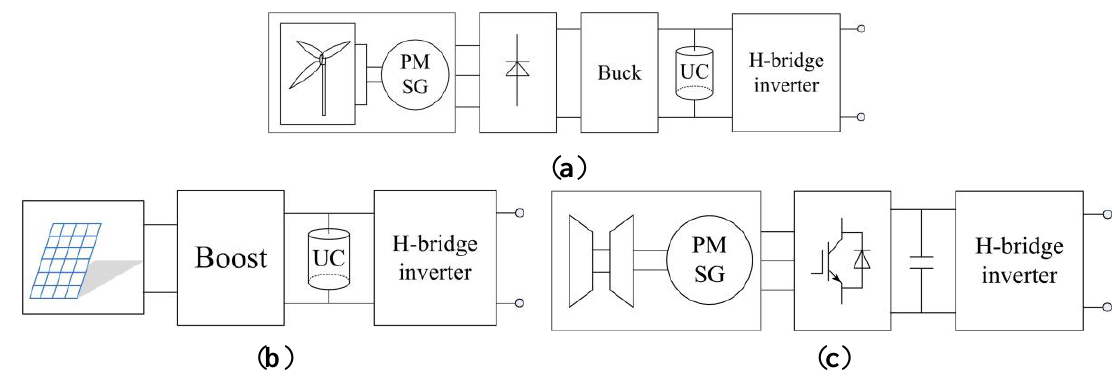
Figure 2. Topology of the distributed energy sources (DES). ( a ) Wind DES; ( b ) solar DES; ( c ) micro gas turbine